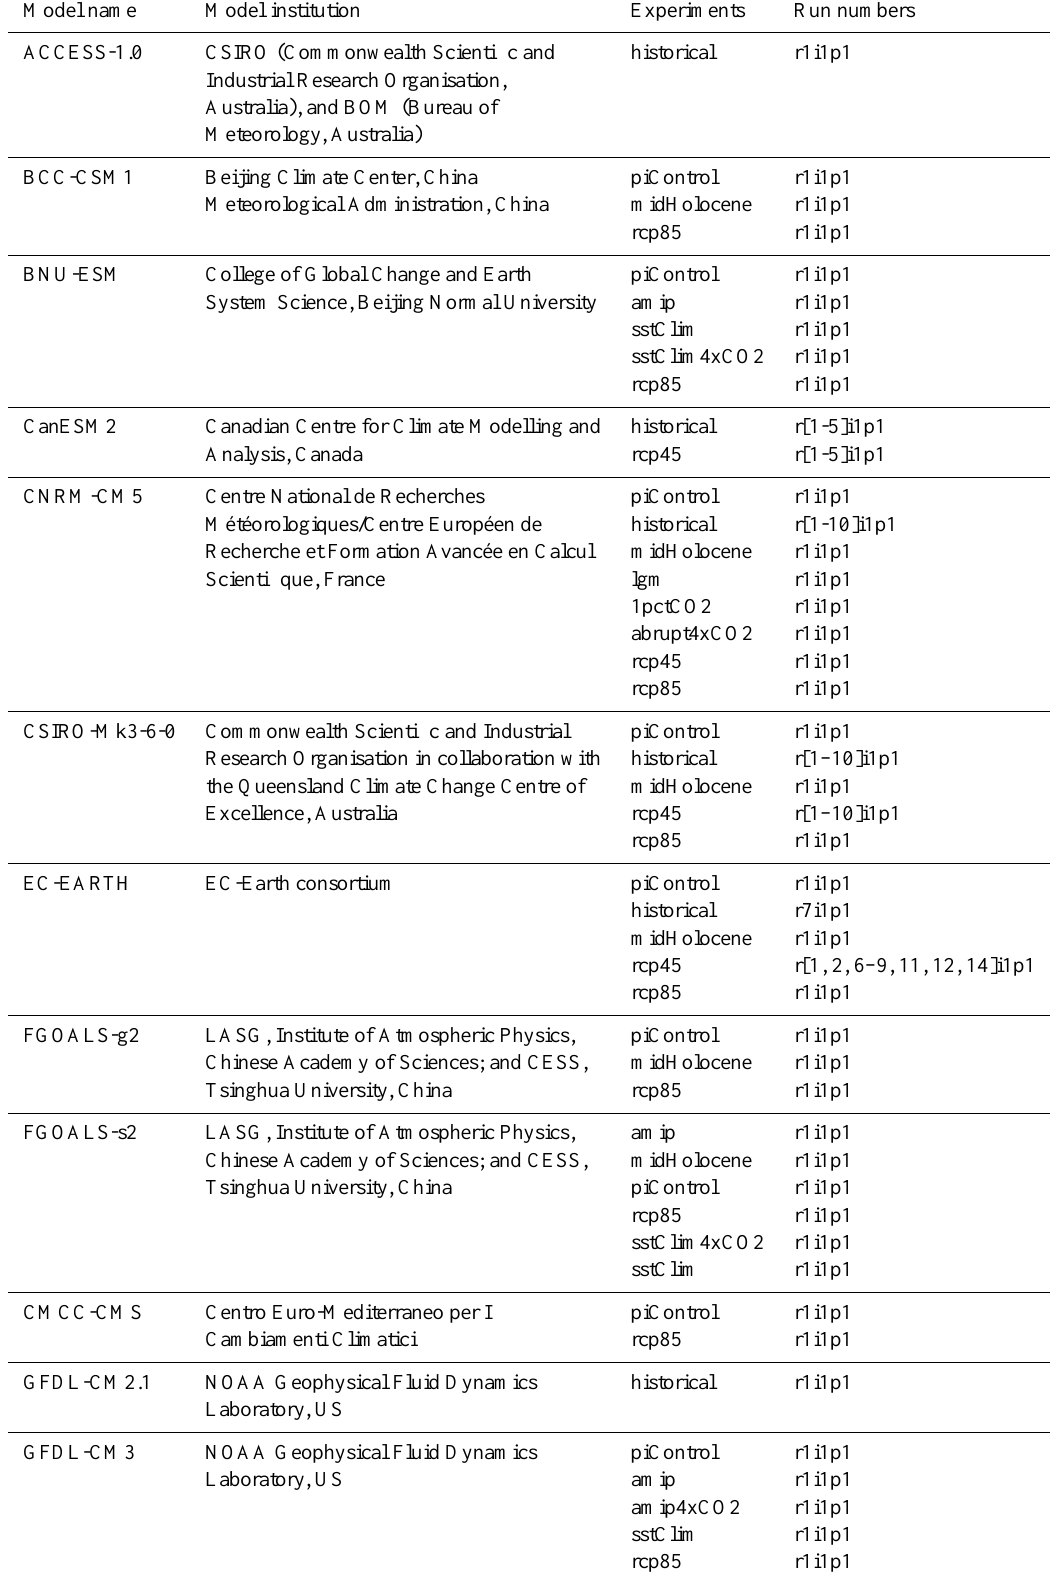
Table 1. List of models, institutions and experiments used in the analyses in this paper. Experiment names use the CMIP5 database shorthand, and run numbers are the “rip” coding for each